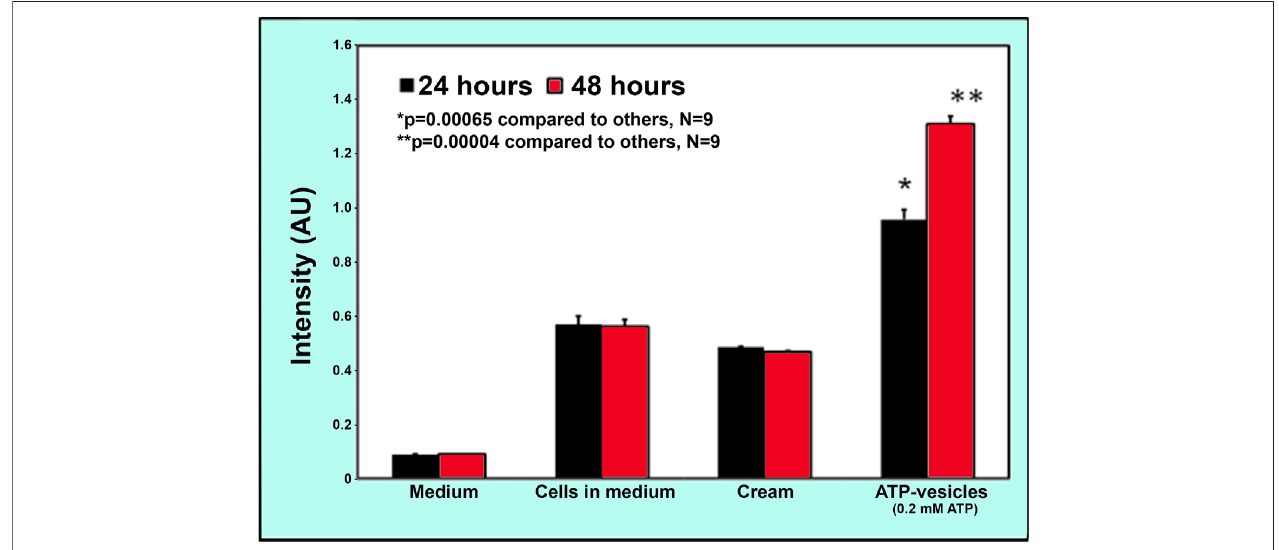
FIGURE 9 | Comparison of collagen production by macrophages in vitro when treated with ATP-vesicles and the control. Addition of 0.2 mM ATP-vesicles to the macrophages in culture for 24 and 48 h increased the collagen release when compared with the control cream alone treatment (Mean ± SD of nine independent experiments p <